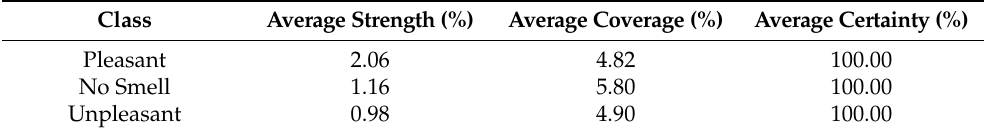
Table A4. Summary of generated